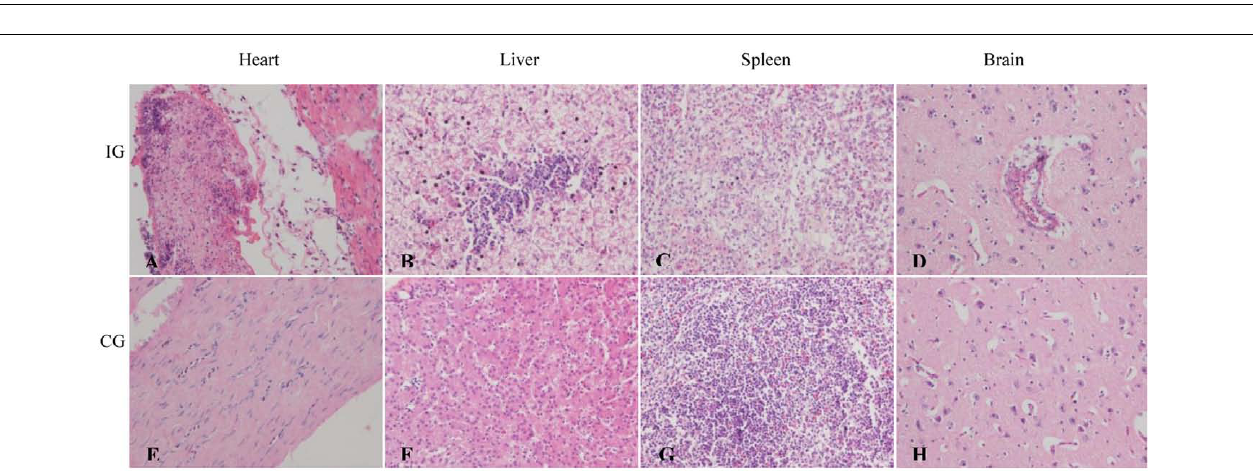
FIGURE 3 | Clinical symptoms and necropsy lesions of the APEC-infected ducks. (A) Listlessness and anorexia; (B) Diarrhea; (C) Heart surface had a layer of yellowish–white fibrinous exudate; (D) Fibrinous exudate in the liver surface; (E) Splenomegaly and hemorrhage; (F) Peritoneal fibrosis adhesions.